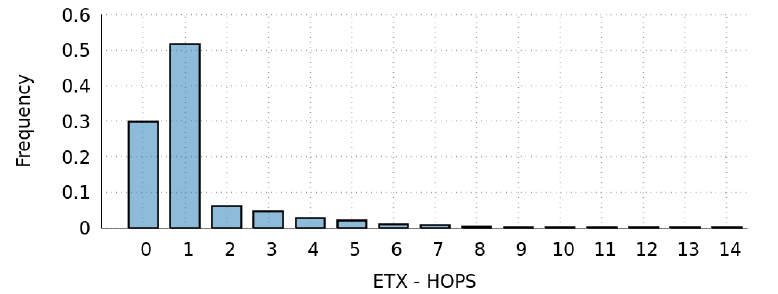
Figure 8. Histogram of deviation between average ETX and number of